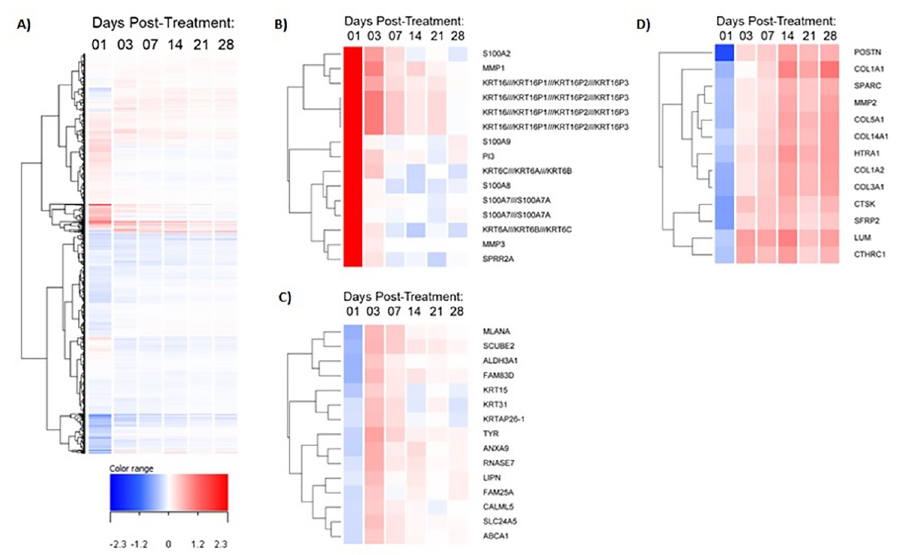
Fig 1. Kinetic effects of single laser resurfacing treatment on gene expression. A) Dendrogram displaying hierarchical clustering of genes by average log 2 fold change that were significantly changed at any one time point compared to baseline untreated samples (n = 15,067 total). B-D) Dendrograms of select gene clusters from A) showing kinetic dysregulation from early ( B , days 1–3), early-to-mid ( C , days 3–7), and mid-to-late ( D , days 14–28) time points following single laser resurfacing